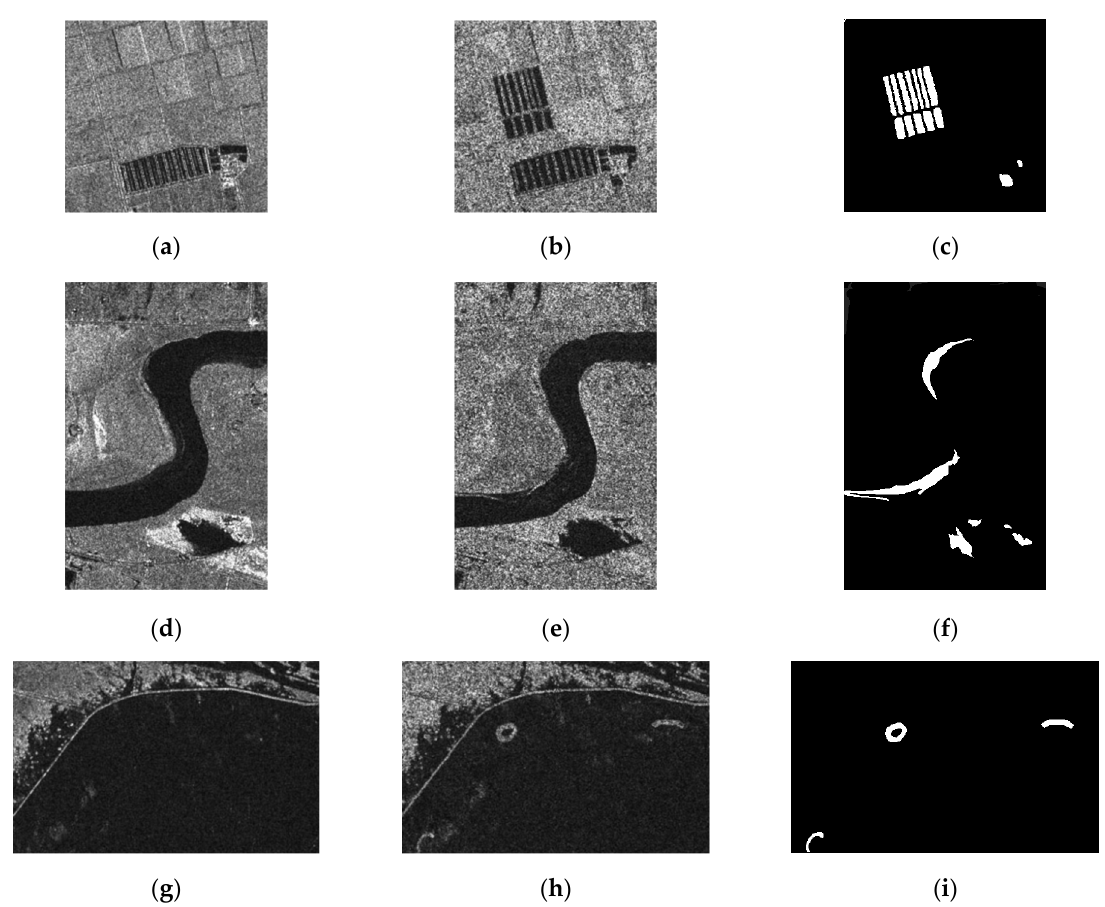
Figure 3. Presents the multi-temporal SAR image data sets used in experiments. Farmland data set with a size of 306×291 pixels. ( a ) Image acquired in June 2008. ( b ) Image acquired in June 2009. ( c ) Ground truth. River data set with a size of 291 × 444 pixels. ( d ) Image acquired in June 2008; ( e ) Image acquired in June2009; ( f ) Ground truth. Coastline data set with a size of 450 × 280 pixels. ( g ) Image acquired in June 2008; ( h ) Image acquired in June2009; ( i ) Ground truth.